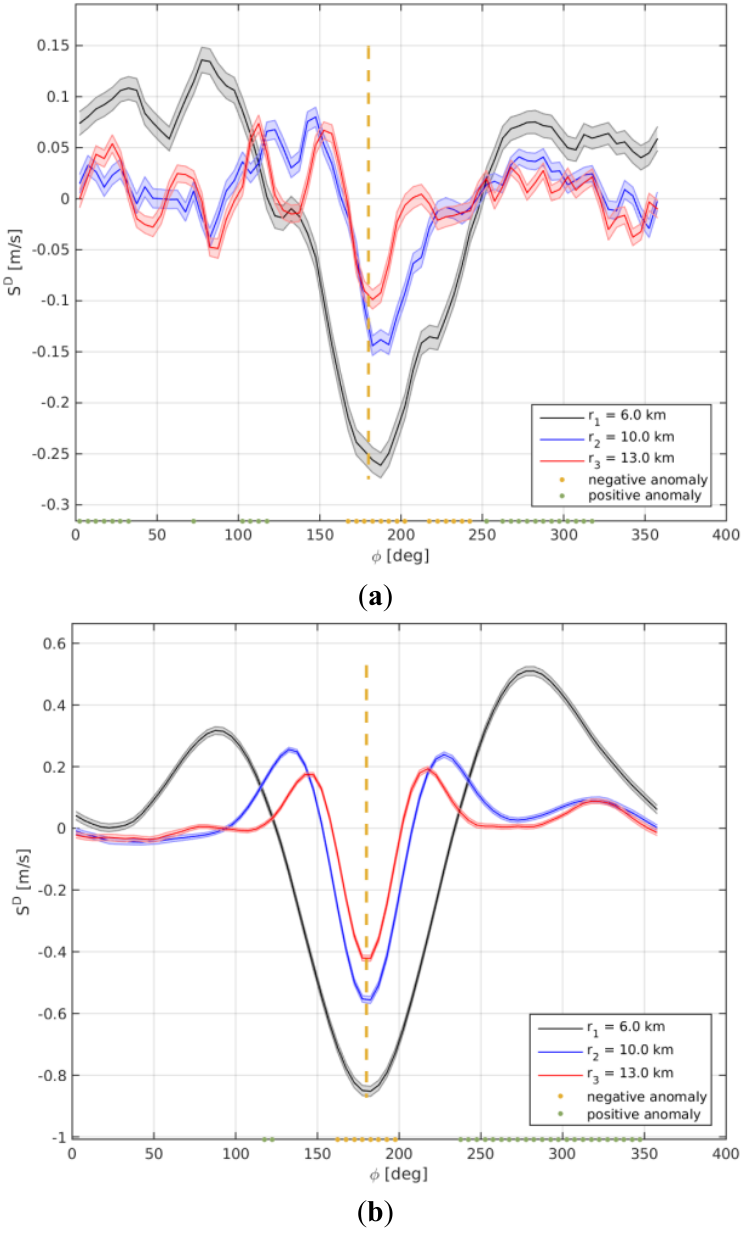
Figure 10. Horns Rev 1 wake wind speed deficit ( S D ) based on SAR ( a ) and WRF ( b ). The shaded areas in SAR indicate the standard